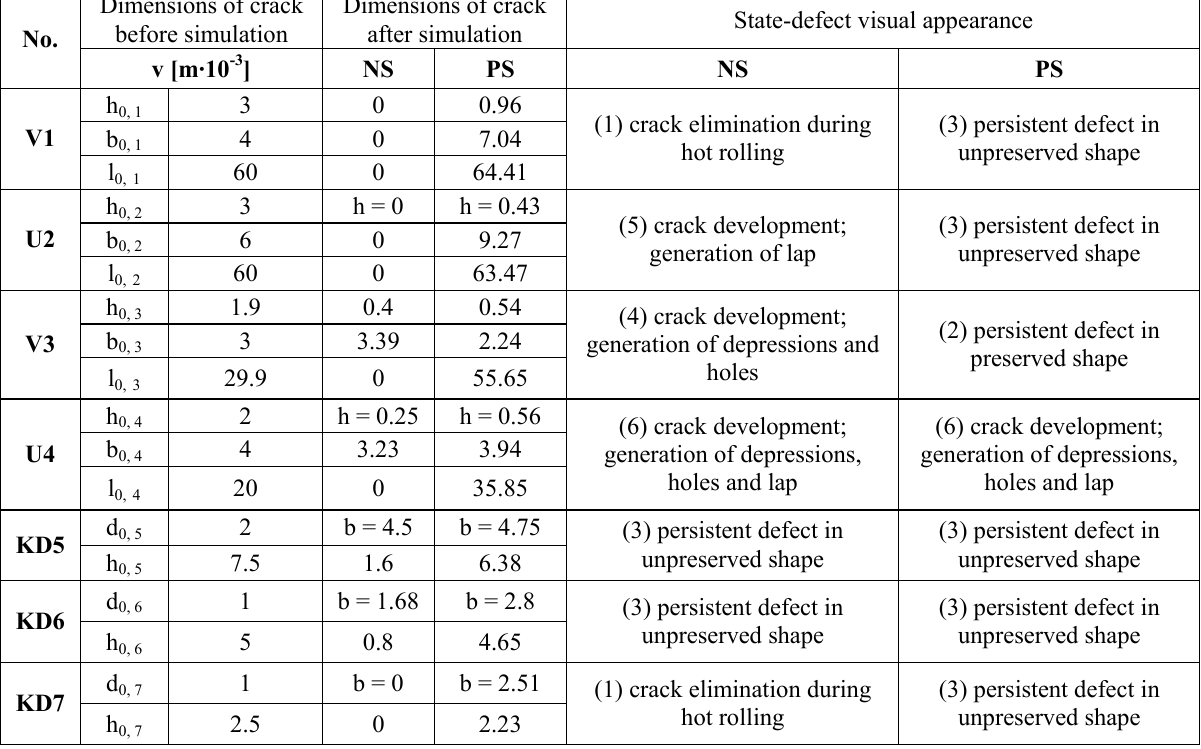
Table 4. State-defect visual appearance after the numerical simulation for regime: T o D 1423 K (1150 °C), T " D 1373 K (1100 °C) and " D 50 %, NS-numerical simulation, PS-physical simulation. the slab surface. Due to these facts, heat transfer and heat generation due to plastic deformation have not been taken into account. The contact times are, however, short and the volume of material are large so that the reliability of the present results should not be strongly violated because of this assumption